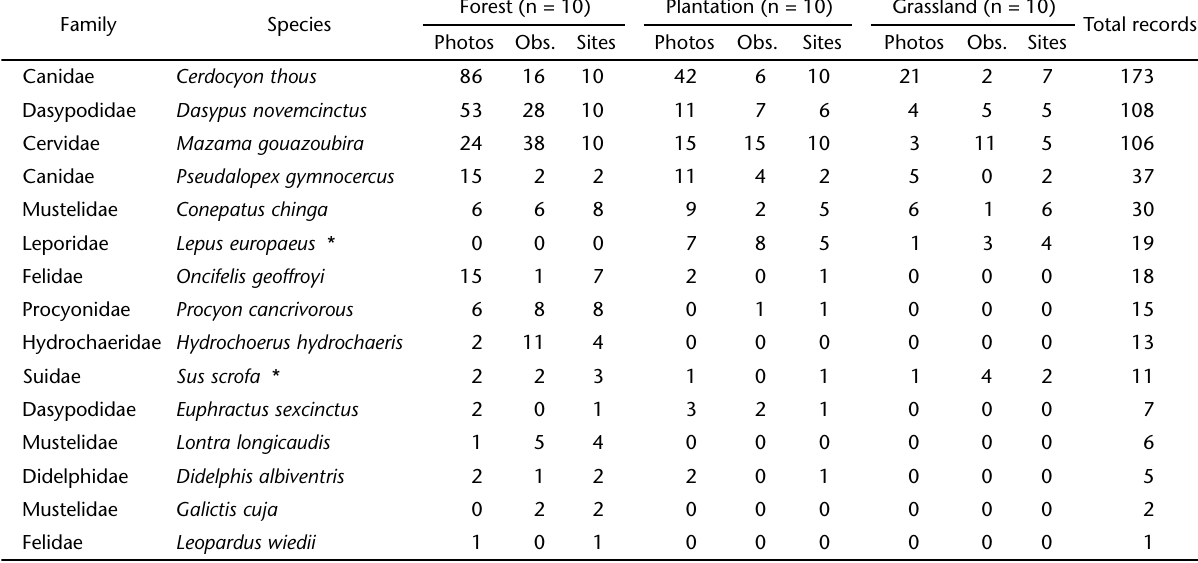
Table I. Number of filtered photos, tracks, scats and direct observations (Obs.) of medium and large mammal species, and the number of sites where a species was recorded. Filtered photos = number of photos determined by assuming that multiple photographs of a species (or a pair or group in the case of foxes and wild boars, respectively) taken by a single camera during any 24-hours period represented a single individual (S ANDERSON 2004). * Exotic species.